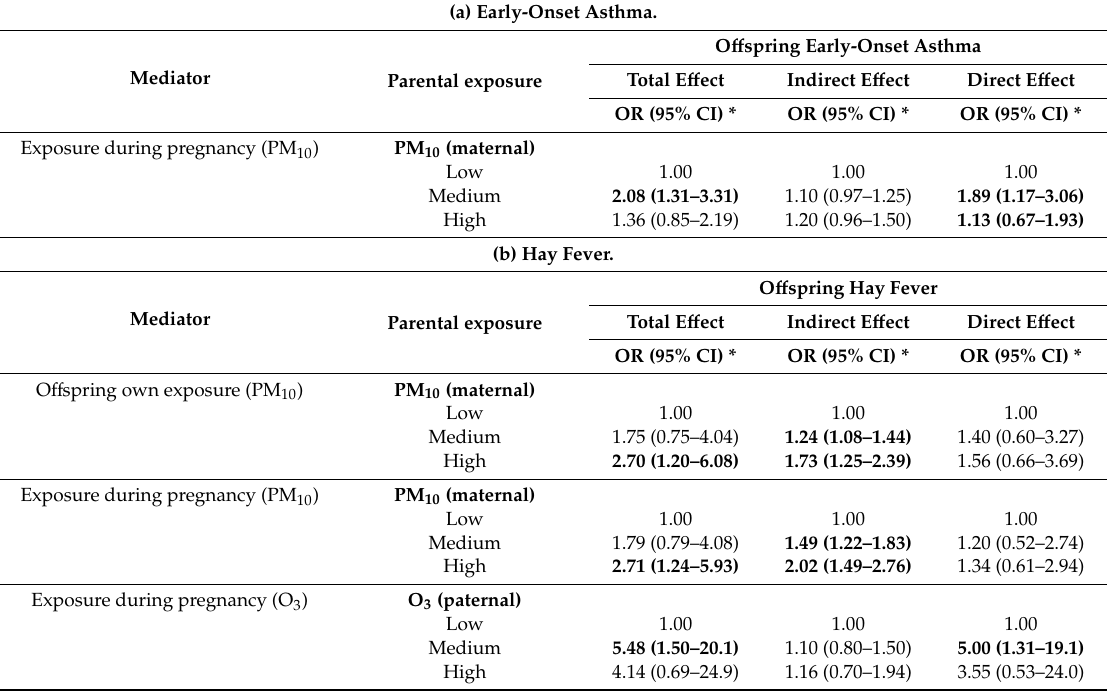
Table 3. Mediation analysis of the association between parental exposure and o ff spring early-onset asthma and hay fever (outcome) through exposure during pregnancy and o ff spring own exposure (potential mediators). (a) Early-Onset